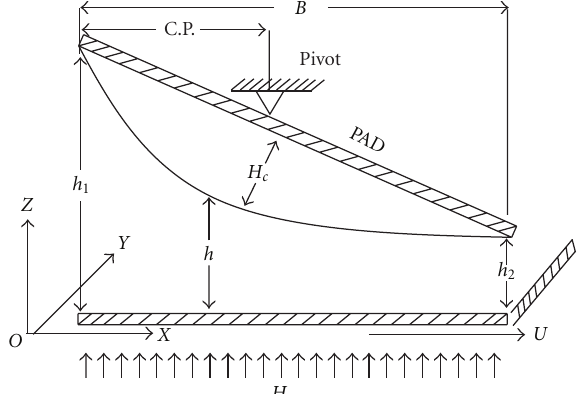
Figure 1: Schematic diagram of a curved slider bearing under applied magnetic field with a pivot at the centre of pressure (C.P.) and H c at B /